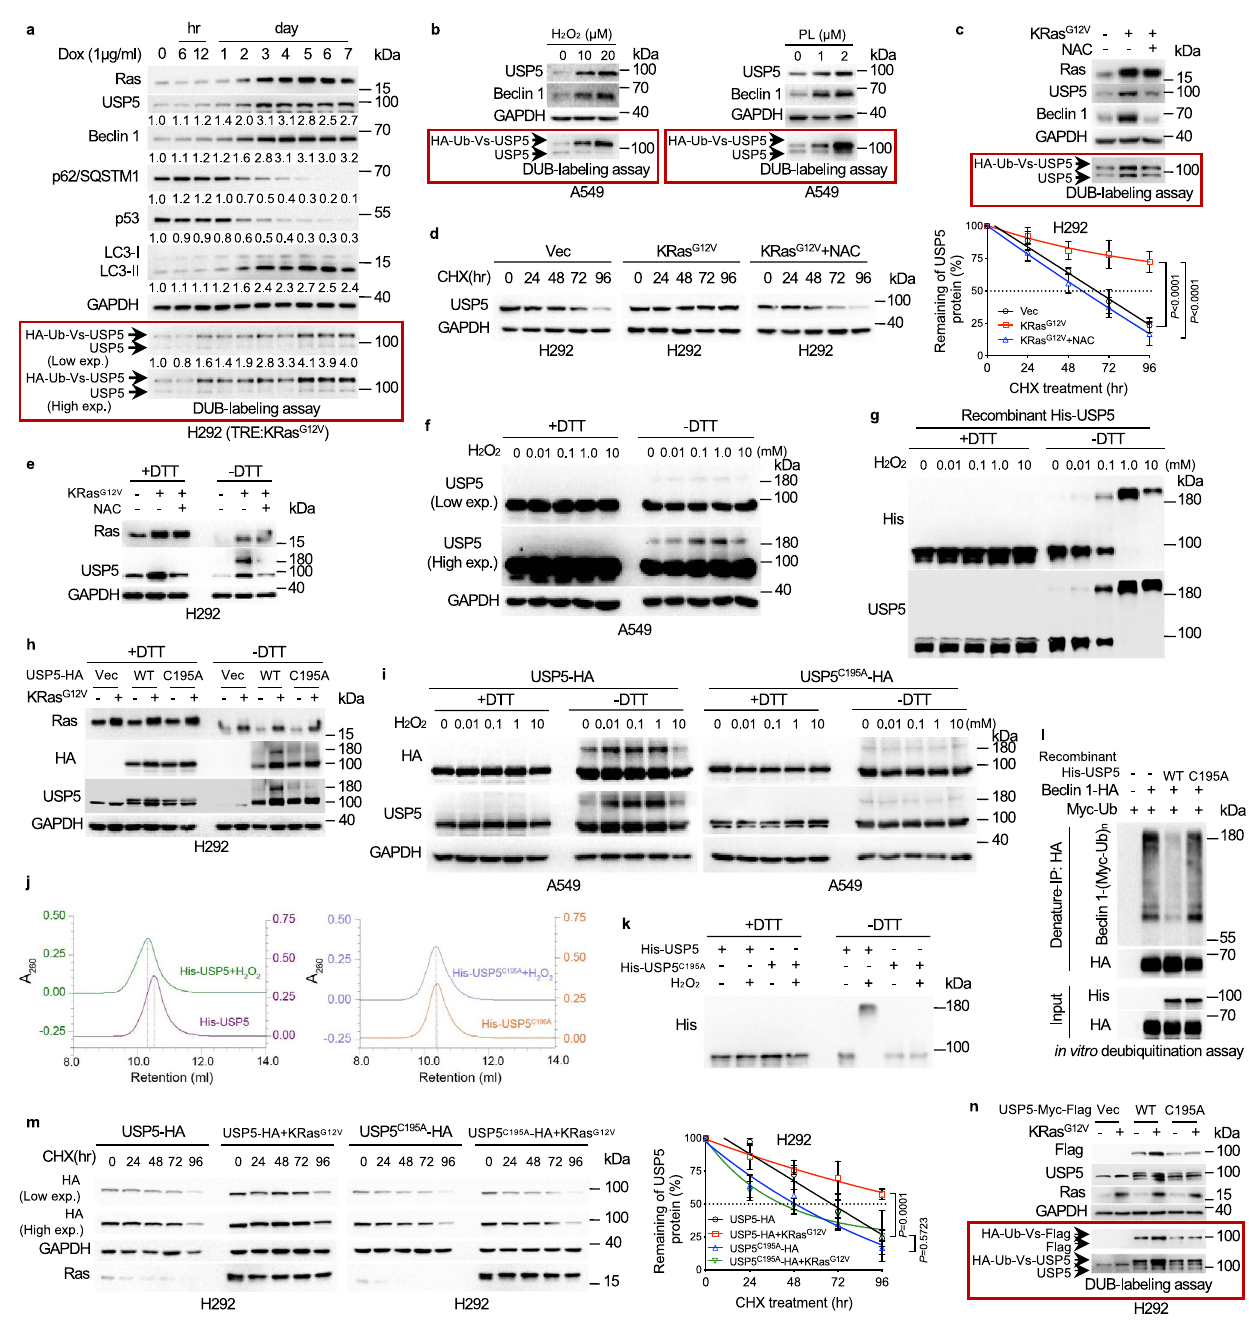
Fig. 5 | KRAS G12V promotes stabilization and activation of USP5 through ROS- induced disul fi de-linked USP5 homodimerization involving C195. a H292 cells harboring doxycycline-inducible KRAS G12V were treated with doxycycline at the indicated time intervals and then subjected to western blot and the DUB-labeling assay for USP5 deubiquitination activity. b A549 cells treated with H 2 O 2 (10 or 20 μ M) or piperlongumine (PL, 1 or 2 μ M) were subjected to western blot analyses and the DUB-labeling assays. c H292 cells stably expressing KRas G12V were treated with 5mM NAC for 24h prior to western blot analyses or DUB-labeling assays. d H292 cells stably expressing KRas G12V were treated in the presence or absence of NAC for 24h, followed by USP5 protein half-life assays. e H292- KRAS G12V cells were treatedwith5mMNACfor24h.TotalcelllysatesweresubjectedtoSDS-PAGEwith or without DTT (100mM) in the loading buffer, followed by western blots. f A549 cellsweretreatedwithH 2 O 2 atanindicateddosefor10minpriortoSDS-PAGEwith or without DTT. g Puri fi ed recombinant His-USP5 protein in PBS was treated with